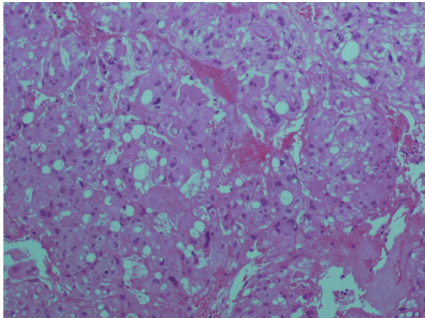
Figure 3: Photomicrographs of the tumor specimen showing lobular architectural pattern with high cellular density and frequent mitosis. Hematoxylin and eosin; magnification: × (200).